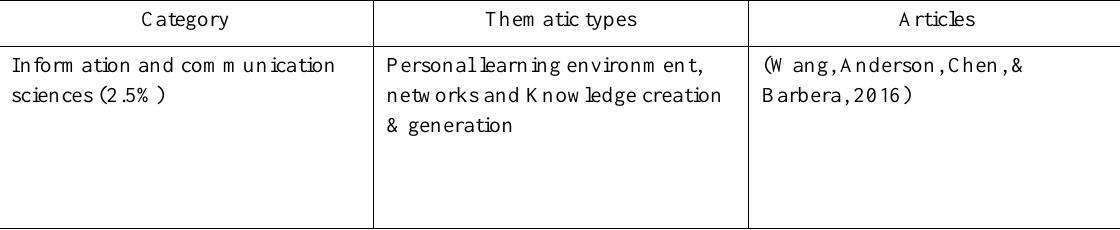
Content Category Information and Communication